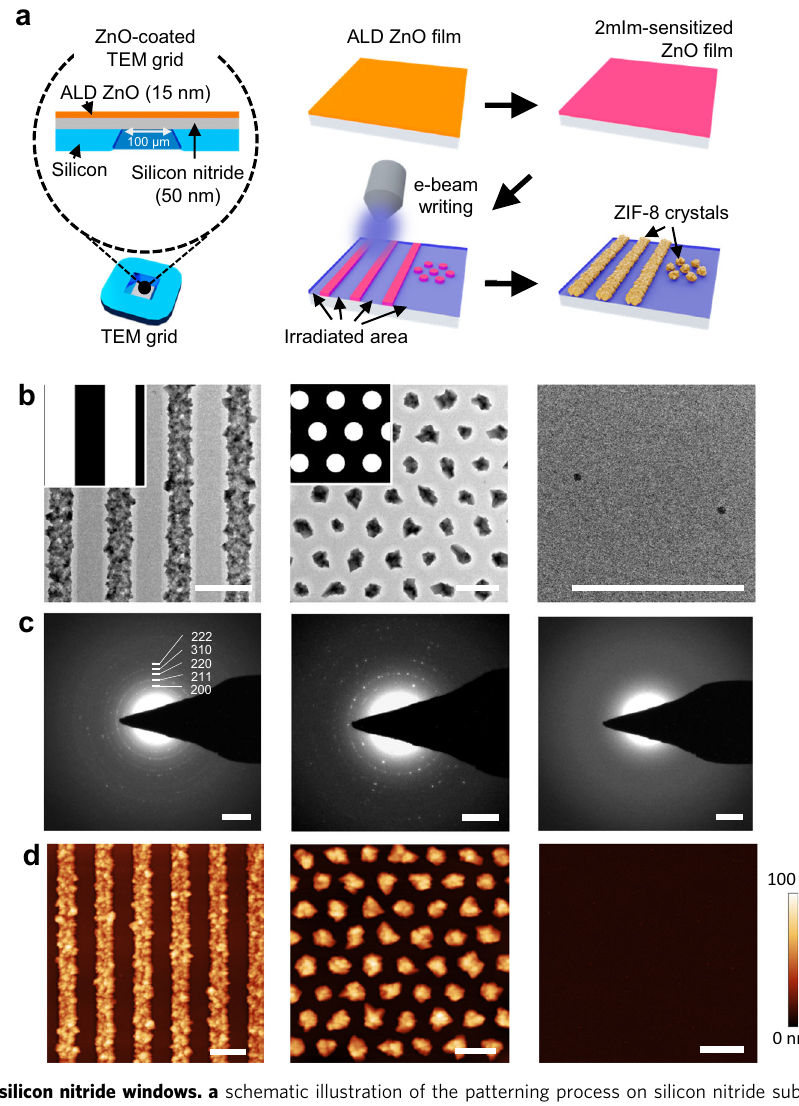
Fig. 2 ZIF-8 patterns on silicon nitride windows. a schematic illustration of the patterning process on silicon nitride substrate. b TEM images of line (500 nm width and 500 nm spacing) and dot (400 nm diameter and 400 nm spacing) patterns and a completely irradiated (non-growth) area, respectively. Irradiated and non-irradiated areas are marked in black and white, respectively, in the top left insets of line and dot patterns in b . c SAED patterns of the imaged areas in b ; diffraction rings corresponding to ZIF-8 are indexed for the line pattern. d AFM height images of different areas on the silicon nitride window corresponding to the TEM images in b . Scale bars are 1 µ m in b and d , and 1 nm − 1 in c